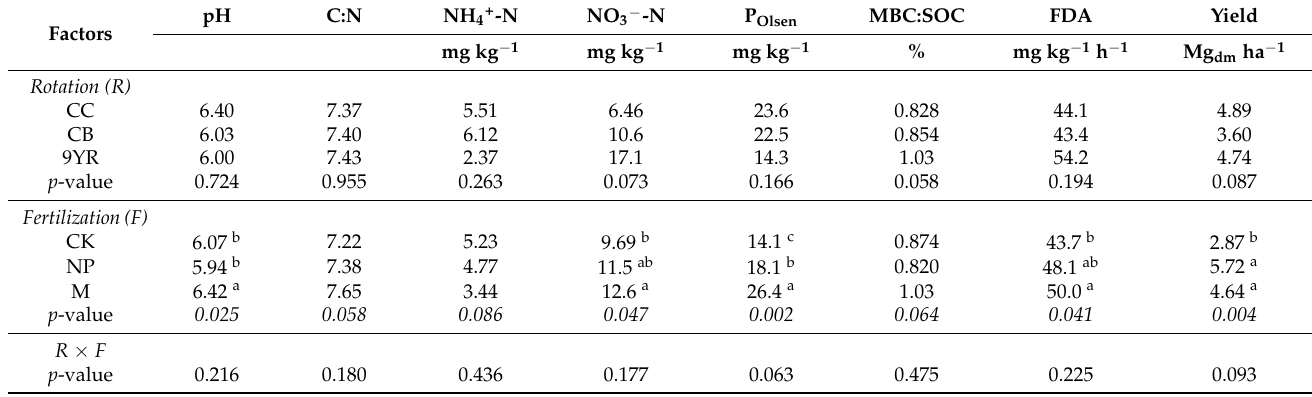
Table 1. Marginal means of soil pH, carbon (C):nitrogen (N) ratio, ammonium (NH 4+ -N), nitrate (NO 3 − -N), available phosphorous (P Olsen ), MBC: soil organic carbon (SOC) ratio, fluoresceine diacetate hydrolysis (FDA), and corn yield for rotation and fertilization effects. Different upper-case and lower-case letters indicate significant differences ( p -value < 0.05), respectively, between rotation and between fertilization as determined by the Fisher’s LSD test. NP: mineral N and phosphorous (P) fertilization. CK: unfertilized control.